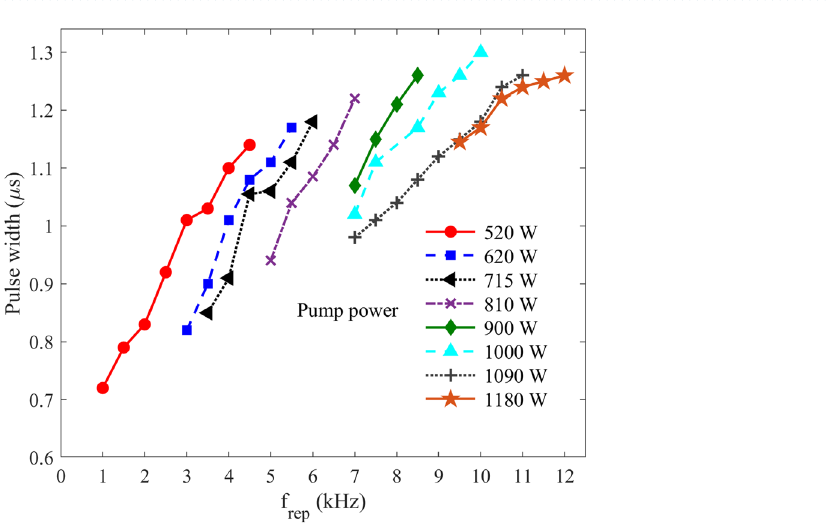
Figure 7. The variation of temporal width of the output pulses versus Q-switching repetition rate for various pump powers. The OC reflectivity was